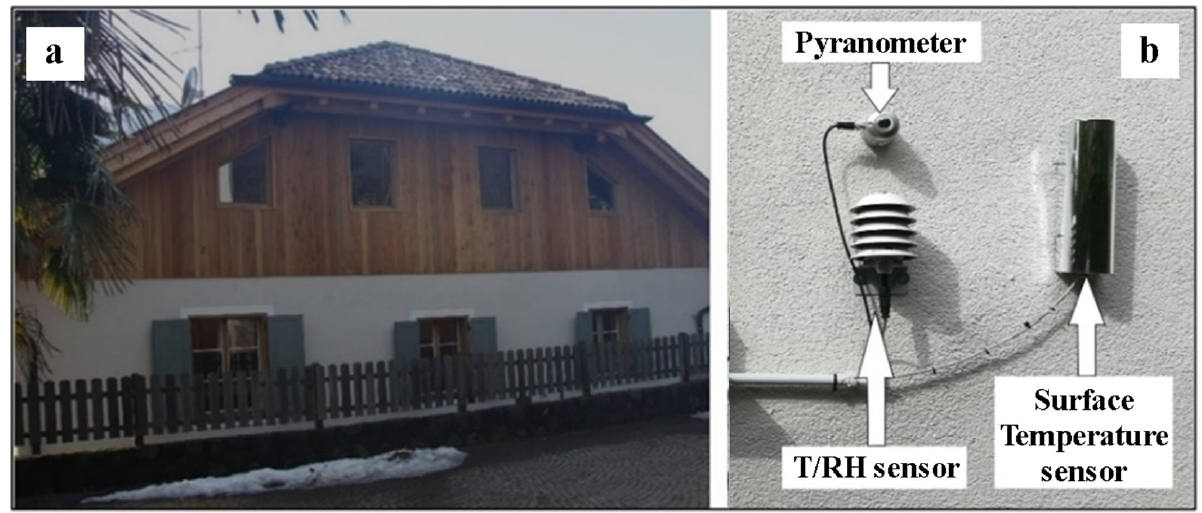
Figure 4. ( a ) Northeast wall monitored. ( b ) External sensors installed (Pyranometer, T/RH sensor, Surface temperature sensor).